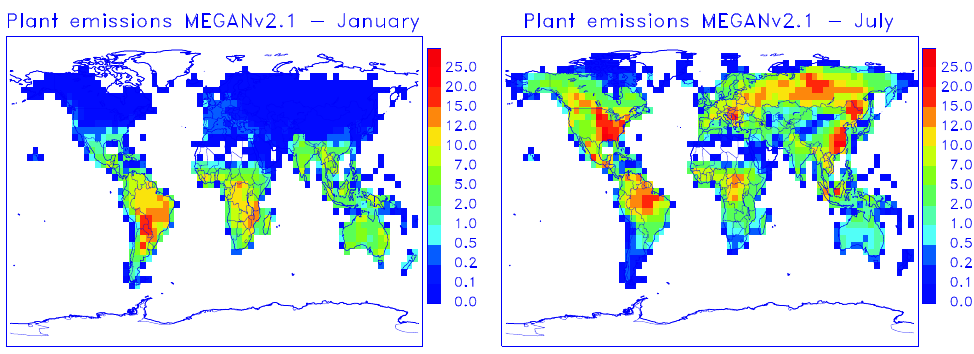
Fig. 1. Global biogenic methanol emissions in January and in July calculated using the MEGANv2.1 algorithm and the MOHYCAN canopy model, and downgraded to the IMAGESv2 model resolution (4 ◦ × 5 ◦ ). Units are 10 10 molcm − 2 s − 1